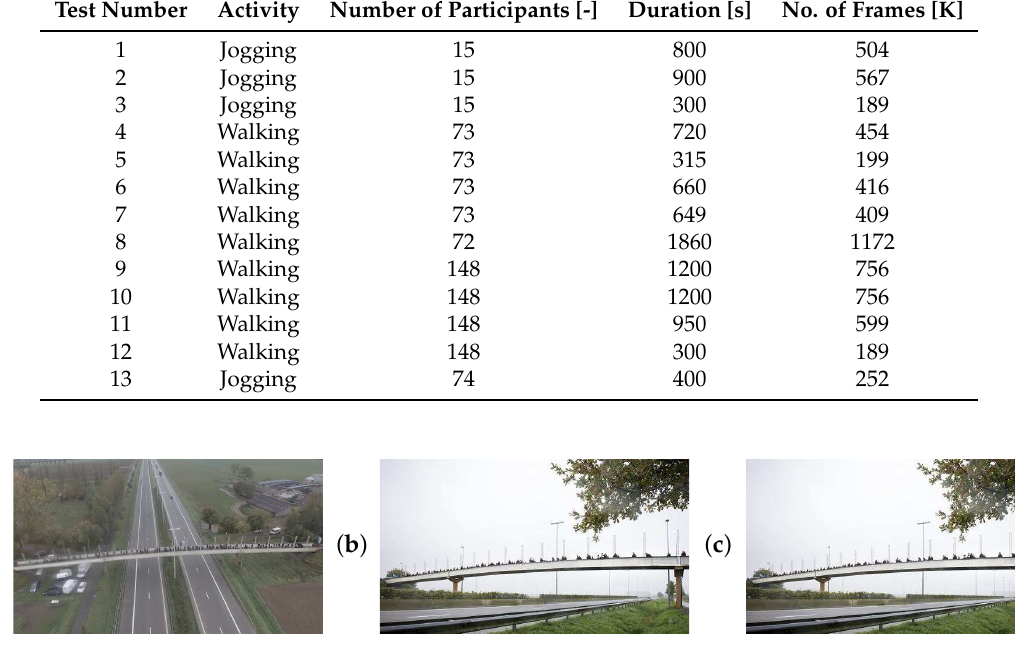
Table 1. Overview of events: name, activity, number of participants, duration and number of video frames recorded by the static camera setup.